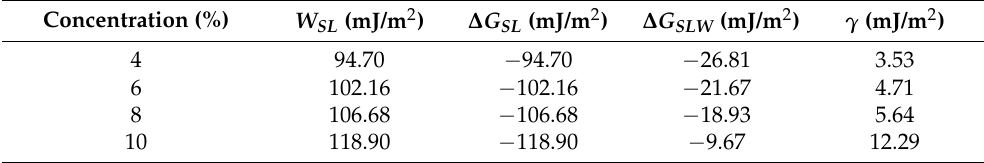
∆ G SL is a negative value, indicating that the energy is released spontaneously when W-OH and the Pisha sandstone adhere to each other. The greater the absolute value is, the better the adhesion between the two is. With an increase in concentration, the absolute value of W SL and ∆ G SL increases, indicating that the higher the concentration of the W-OH, the better the adhesion between W-OH and the Pisha sandstone. Similarly, the negative